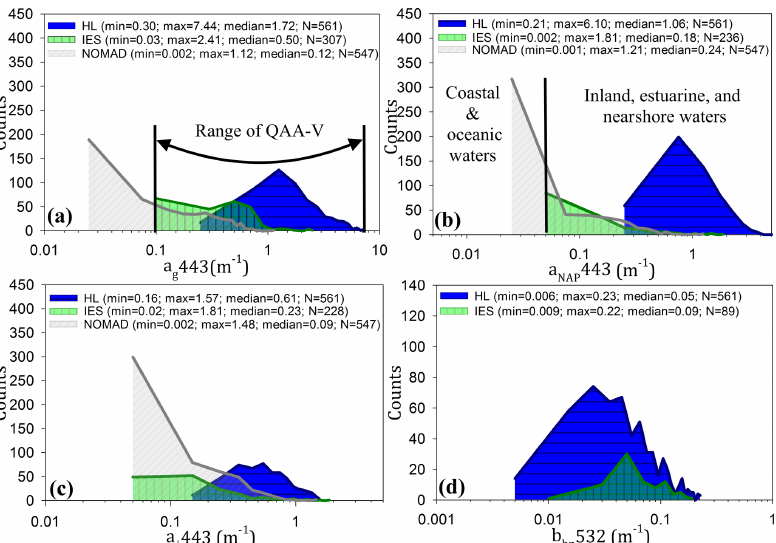
Figure 2. Data statistics and distribution of water IOPs, (a) a g 443, (b) a NAP 443, (c) a φ 443, and (d) b btnw 532 for synthetic data (HL, Hydrolight ® ; blue), in situ estuarine and nearshore data (IES; green), and the NOMAD (grey). The range of QAA-V indicates data that are used to update QAA-V for shallow waters (e.g., HL and